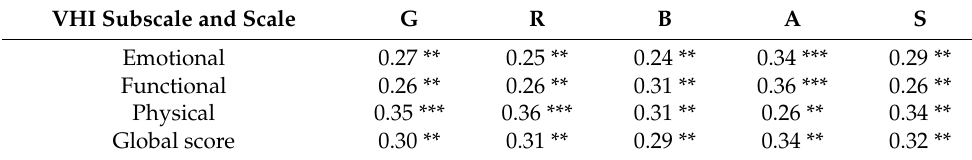
Table 3. Rho-Spearman correlations between VHI-POL scores and GRBAS (study group).